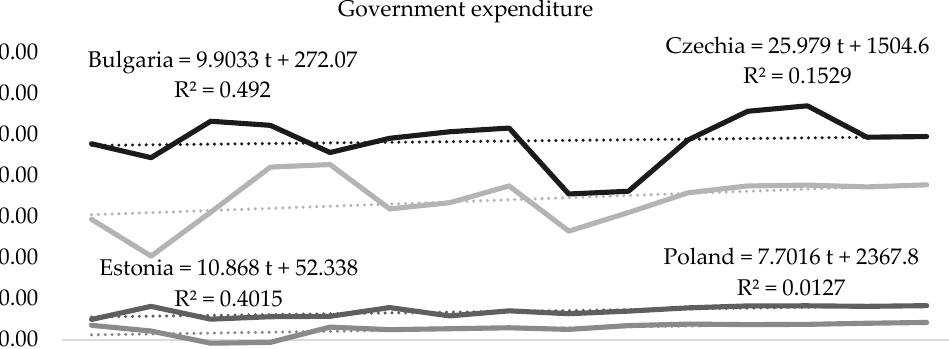
Figure 1. Sustainable development of energy sector enterprises and its pillars in the analyzed countries from 2008 to 2022 (dotted line is SD trend line). Source: own elaboration. Figure 2 shows selected energy economy factors in Bulgaria, Czechia, Estonia, and Poland from 2008 to 2022. In all countries, the indicators of government expenditure, environmental taxes, outlays on renewable energy sources, the prices of futures contracts for CO 2 emissions, and outlays on R&D display a growing trend, while the indicators of the EU Emissions Trading System is decreasing, which should be assessed positively.